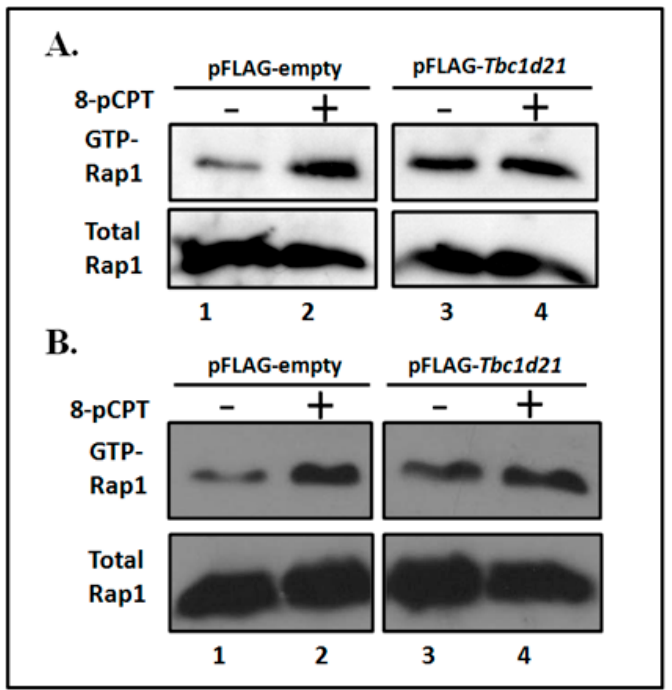
Figure 6. TBC1D21 regulates Rap1 activity. ( A , B ) NT2D1 cells were transfected with pFLAG-empty (Lanes 1 and 2) or pFLAG- Tbc1d21 (Lanes 3 and 4). Cell lysates were subjected to Rap1 activation through treatment with 8-pCPT-2 ′ -O-Me-cAMP (8-pCPT) (Lanes 2 and 4) or mock treatment (Lanes 1 and 3). Following IB with the anti-Rap1 antibody (upper panel), activated Rap1 was incubated with the Glutathione S-transferases (GST)-Rap-binding domain, and then pulled down using anti-GST antibodies. An equal amount of cell lysates were immunoblotted with the anti-Rap1 antibody as a control. “+”: add 8-pCPT; “ − ”: absent 8-pCPT.